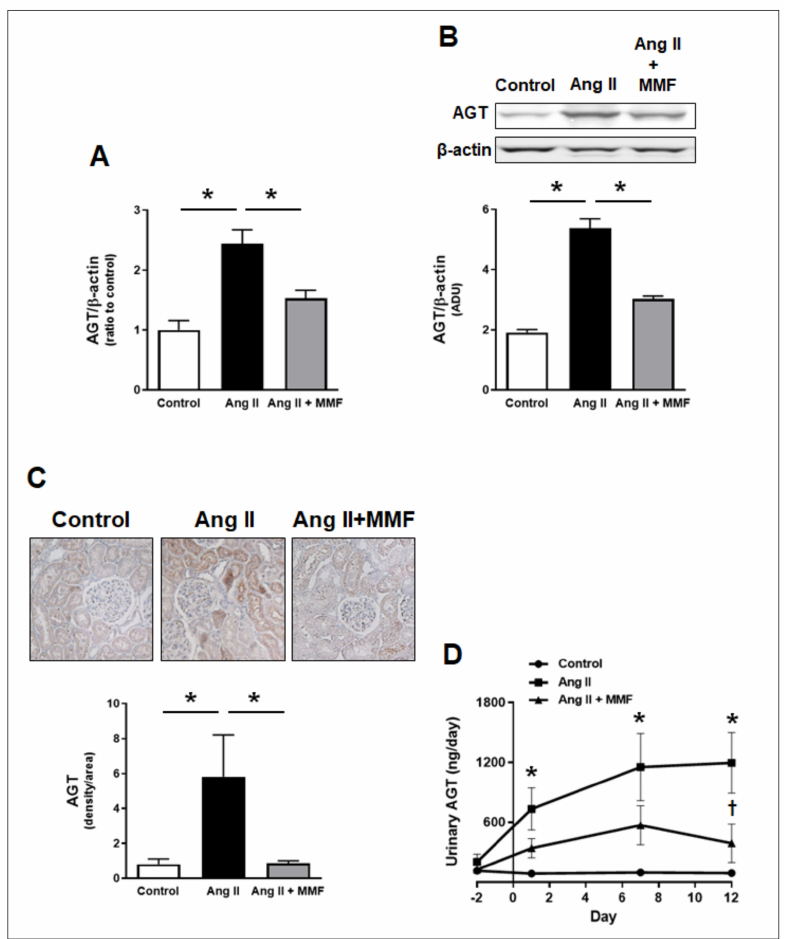
Figure 3. Effects of MMF on intrarenal and urinary AGT levels. Panel ( A ) indicates renal cortical AGT mRNA levels ( n = 6). Panels ( B , C ) show renal cortical AGT protein levels detected by Western blot analyses and immunological staining, respectively ( n = 6). The brown color in the images indicates positive areas. The bar graphs show the percentile of density of positive areas in the total image. The scoring method for the images is described in the Method section. Urinary AGT levels determined by an ELISA are presented in panel ( D ) ( n = 6). In panels ( A – C ), an asterisk ( p < 0.05) indicates significant difference between the groups. In panel ( D ), an asterisk ( p < 0.05) indicates significant difference compared to the control group and the dagger ( p < 0.05) shows significant difference between Ang II-infused and Ang II + MMF